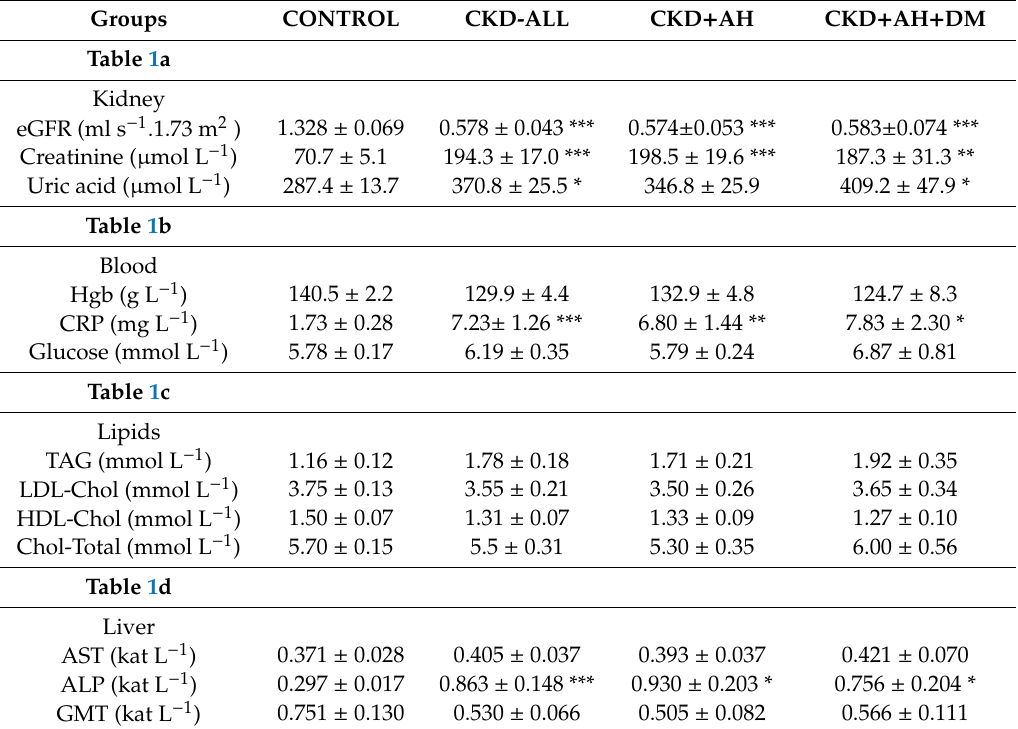
Metabolic parameters of human volunteers and groups of chronic kidney disease (CKD)